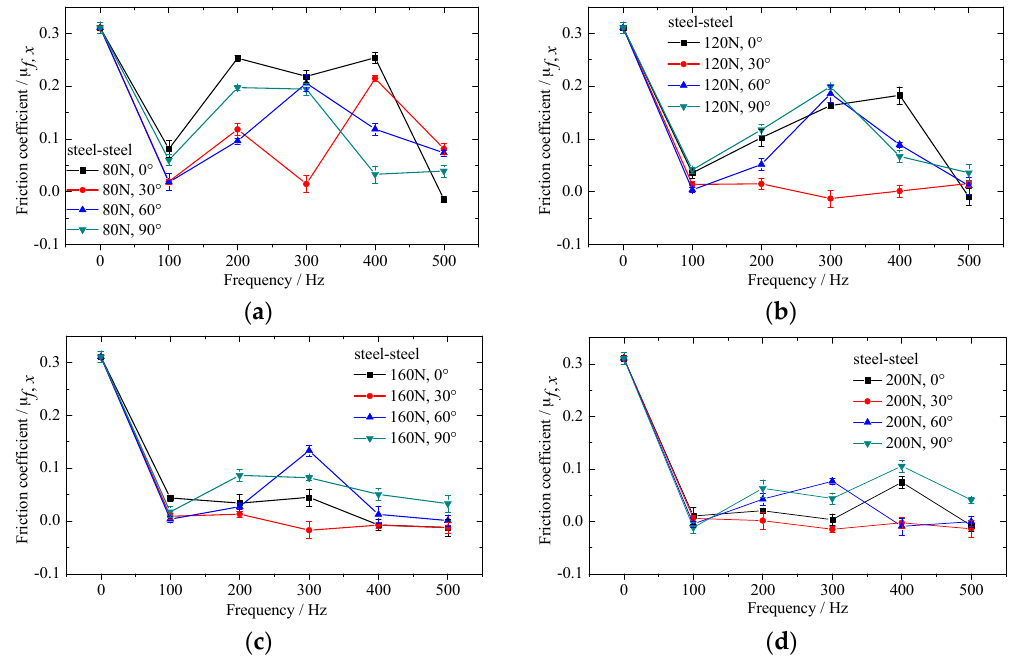
Figure 5. Effect of in-plane vibration on frictional coefficient between alloyed steel and steel. ( a ) Exciting force equals to 80N; ( b ) exciting force equals to 120N; ( c ) exciting force equals to 160N and ( d ) exciting force equals to 200N.